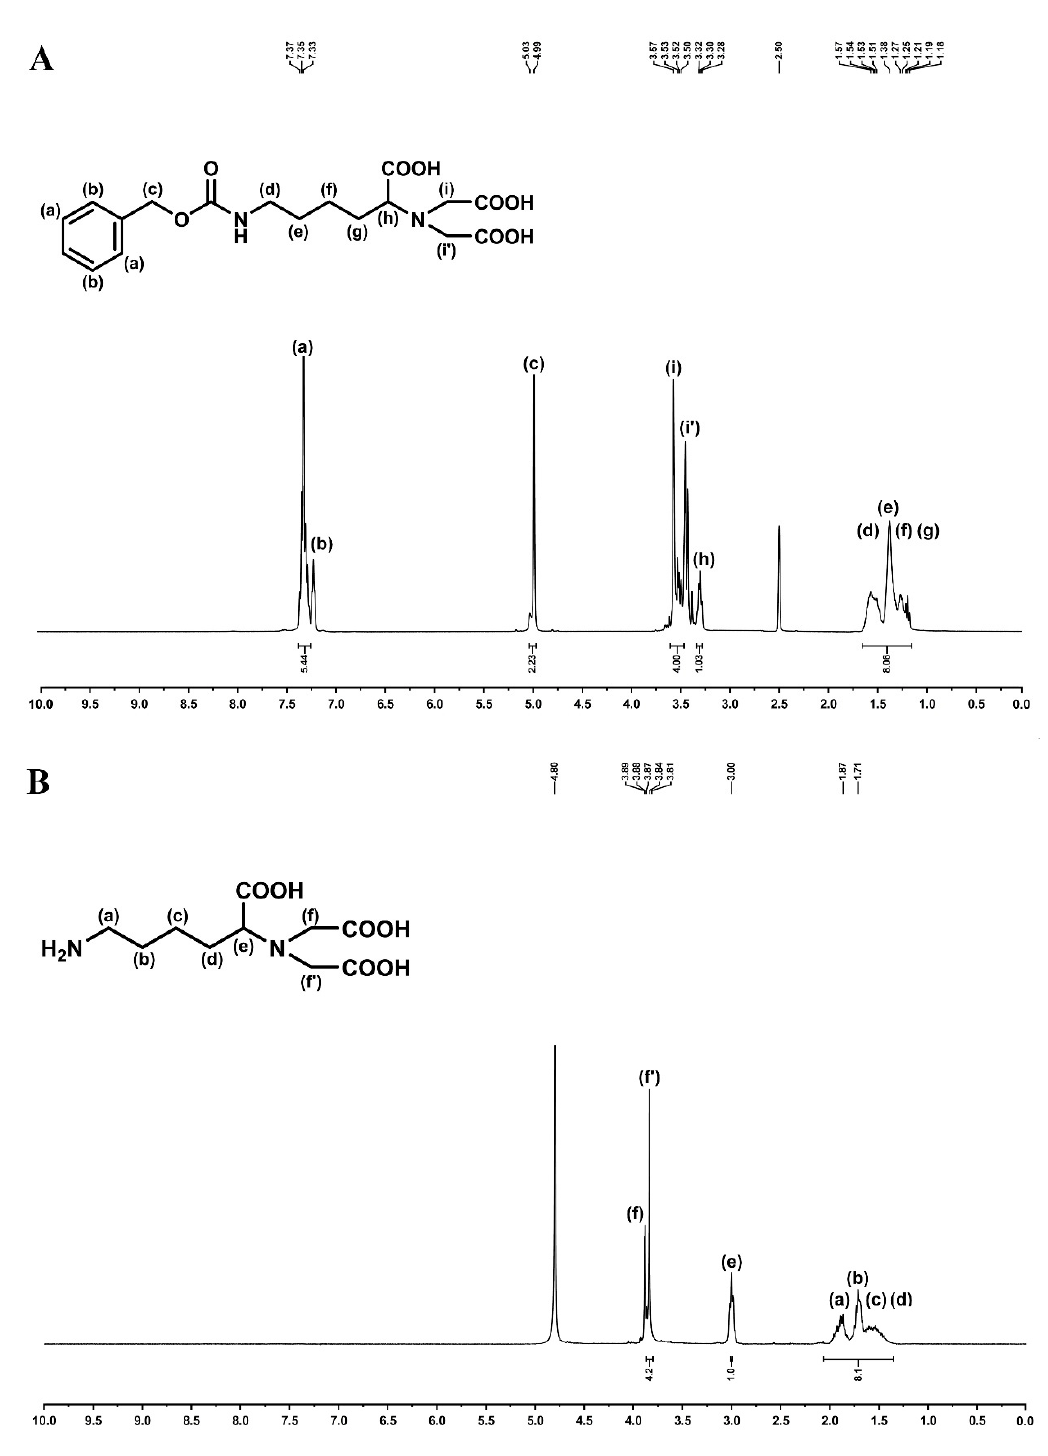
Figure 8. Analysis of the hydrogenation of N 6 -carboxybenzyloxy- N 2 , N 2 -bis(carboxymethyl)lysine. ( A ) 1 H NMR spectrum of N 6 -carboxybenzyloxy- N 2 , N 2 -bis(carboxymethyl)lysine in DMSO-d 6 . 1 H NMR signals of this compound were 7.25–7.40 (m, 5H), 7.21 (t, 1H, J = 5.5 Hz), 4.98 (s, 2H), 3.46 (m, 4H), 3.33 (t, 1H, J = 7.2 Hz), 2.85–3.05 (m, 2H), 1.15–1.65 (m, 6H) and 1.40–1.90 (m, 6H). ( B ) 1 H NMR spectrum of the fully hydrogenated product, N 2 -bis(carboxymethyl)lysine, in DMSO-d 6 . 1 H NMR signals of the desired product were 3.75–3.90 (m, 5H), 2.89 (t, 2H, J = 7.2 Hz), and 1.40–1.90 (m, 6H).